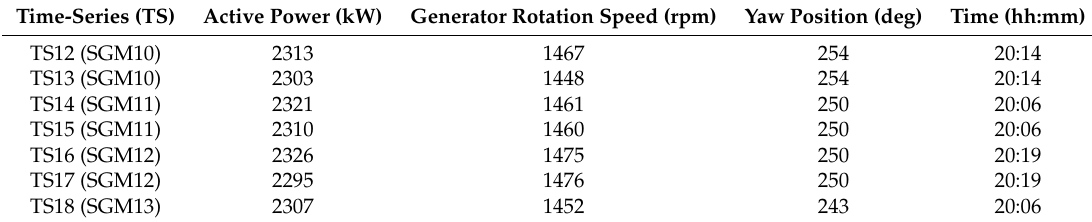
Table 4. Working conditions of turbines SGM10, SMG11, SMG12 and SMG13 related to the results shown in Figure 14.